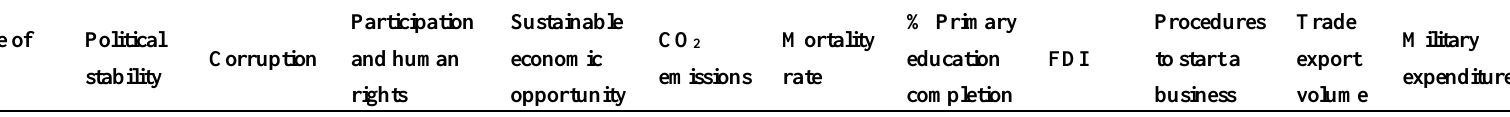
Table 1. Pearson correlation matrix between